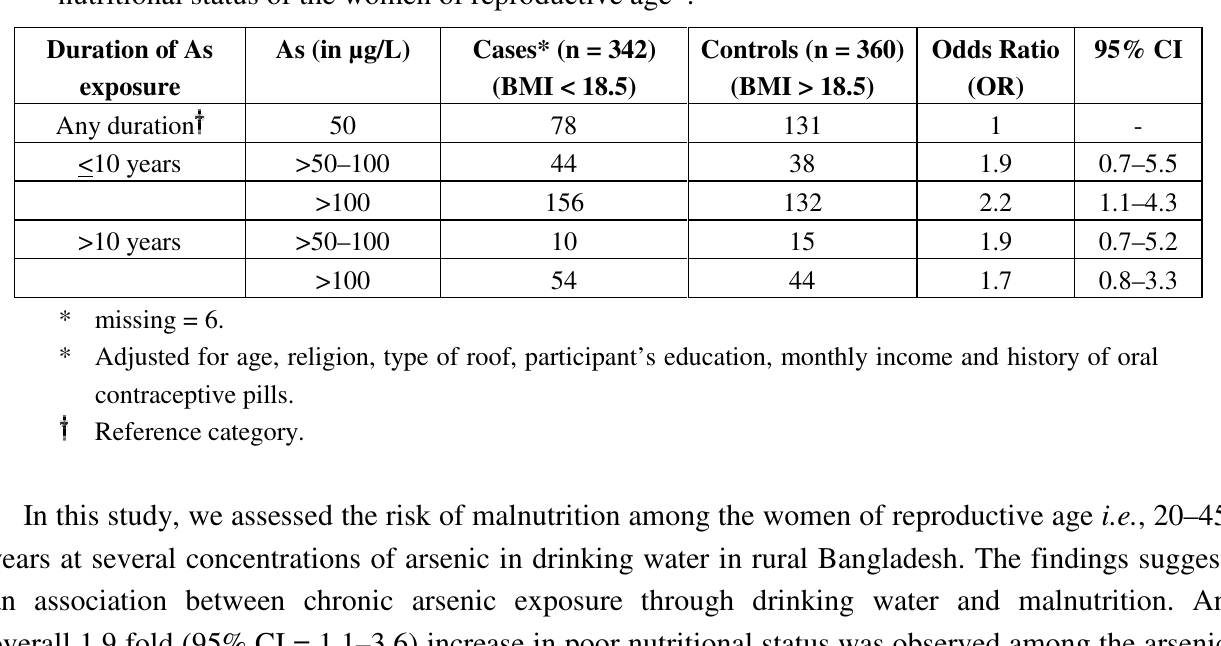
Table 3. Association between arsenic concentrations and duration of exposure with nutritional status of the women of reproductive